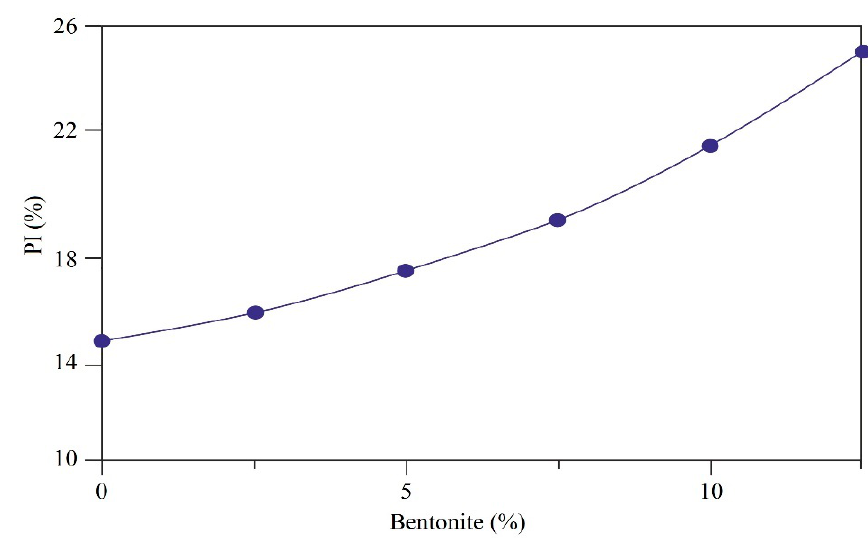
Figure 2. Effect of Bentonite additive on PI index in clayey soil.